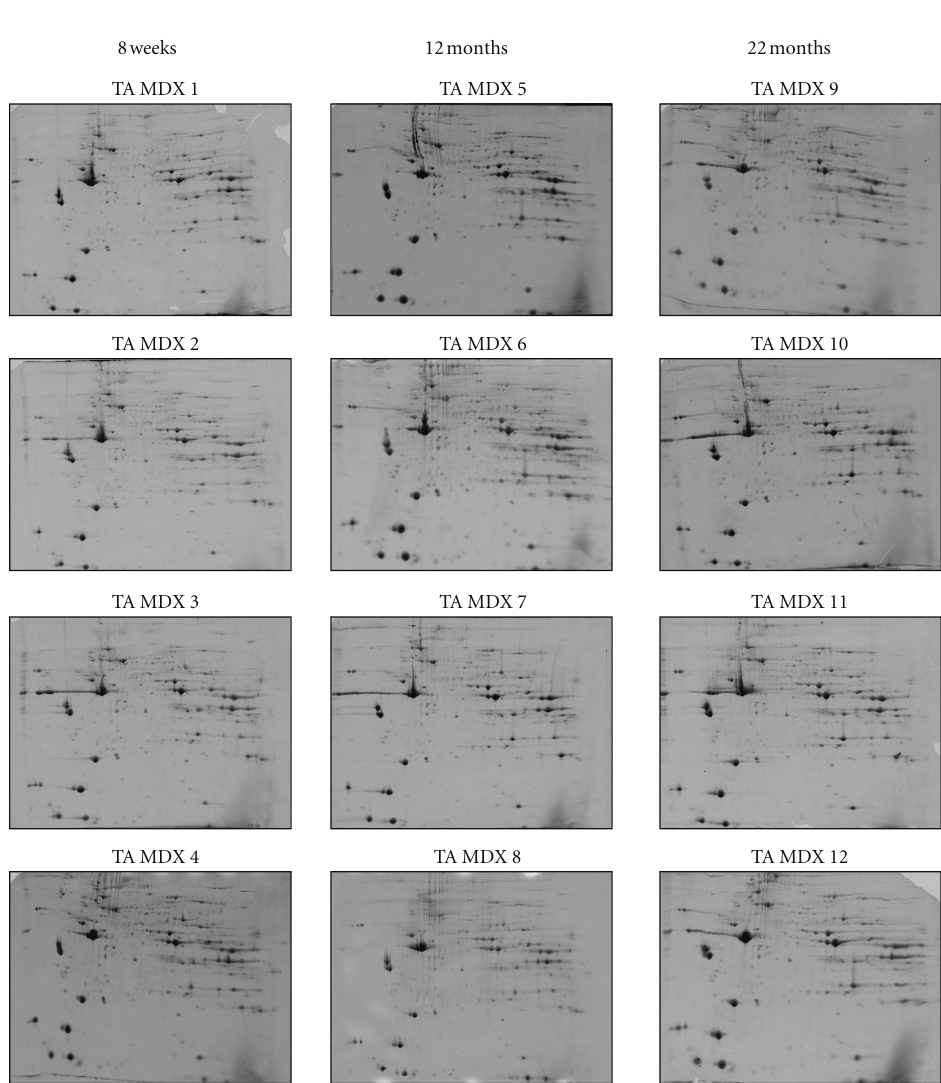
Figure 2: Two-dimensional gel electrophoretic analysis of aging mdx tibialis anterior muscle. Shown are RuBPs-stained gels of total extracts from 8 weeks (TA MDX 1 to 4), 12 months (TA MDX 5 to 8), and 22 months (TA MDX 9 to 12) old tibialis anterior muscle. Fluorescent images are shown for the pH 3–10